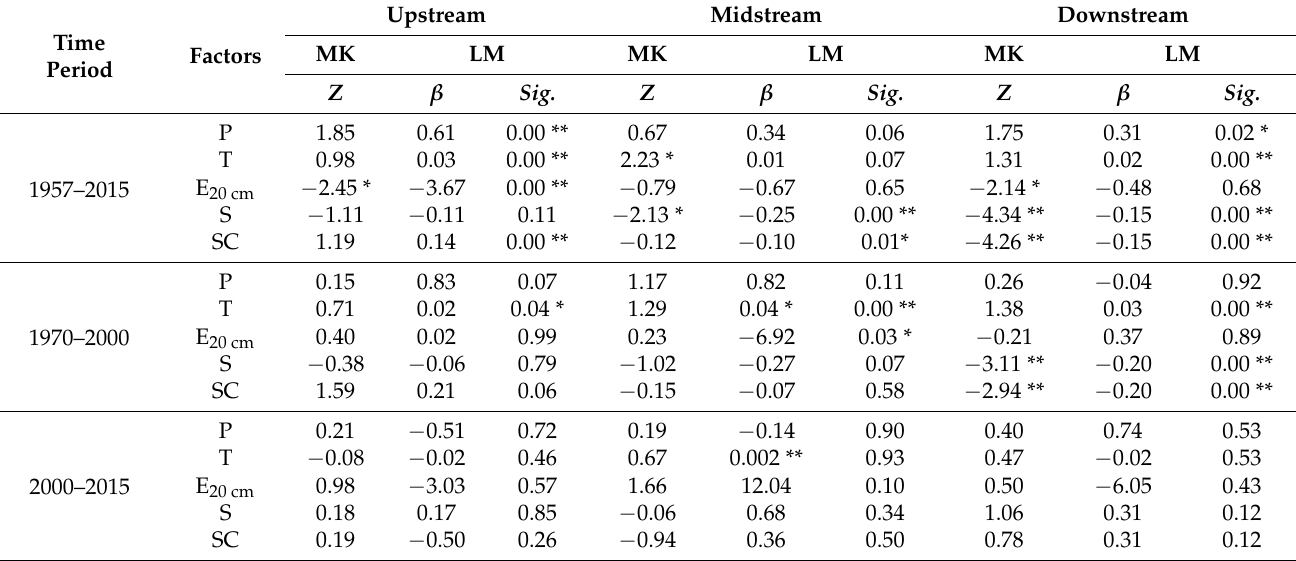
Table 1. Significance of climatic and hydrological variables for the period 1957–2015 (MK: Z value is the standard normal variate for the Mann–Kendall test; LM: β value is the slope of the regression line; Sig. is the p -value for the linear model